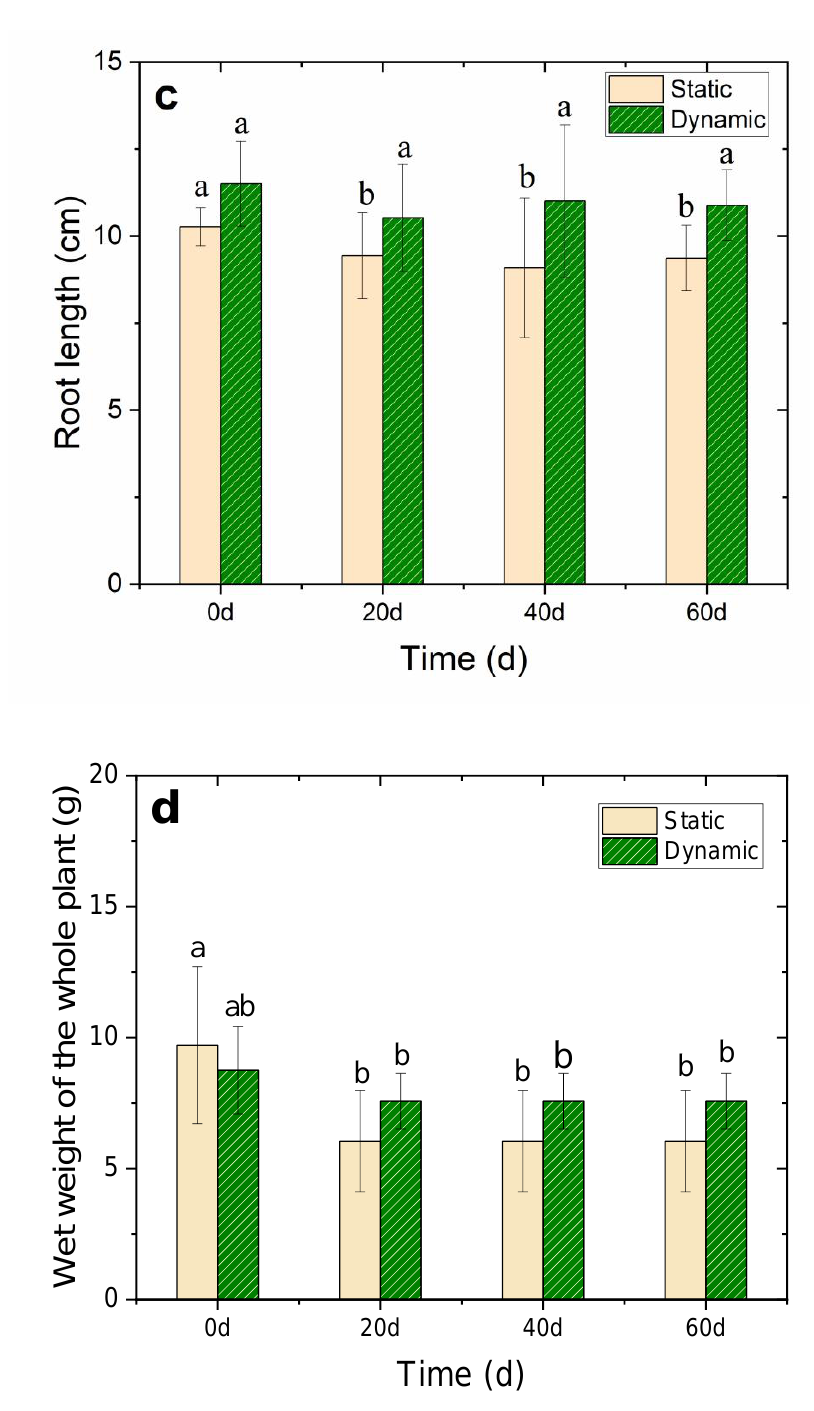
Figure 2. Effects of 35 cm · s − 1 water flow velocity on ( a ) leaf length, ( b ) leaf width, ( c ) root length, and ( d ) wet weight of the whole V. natans plant during the 60-day cultivation period. The lowercase letters above each ivory static or green dynamic bar indicate significant differences ( p < 0.05) in response to different treatments, and all data had a mean value of ± SD.